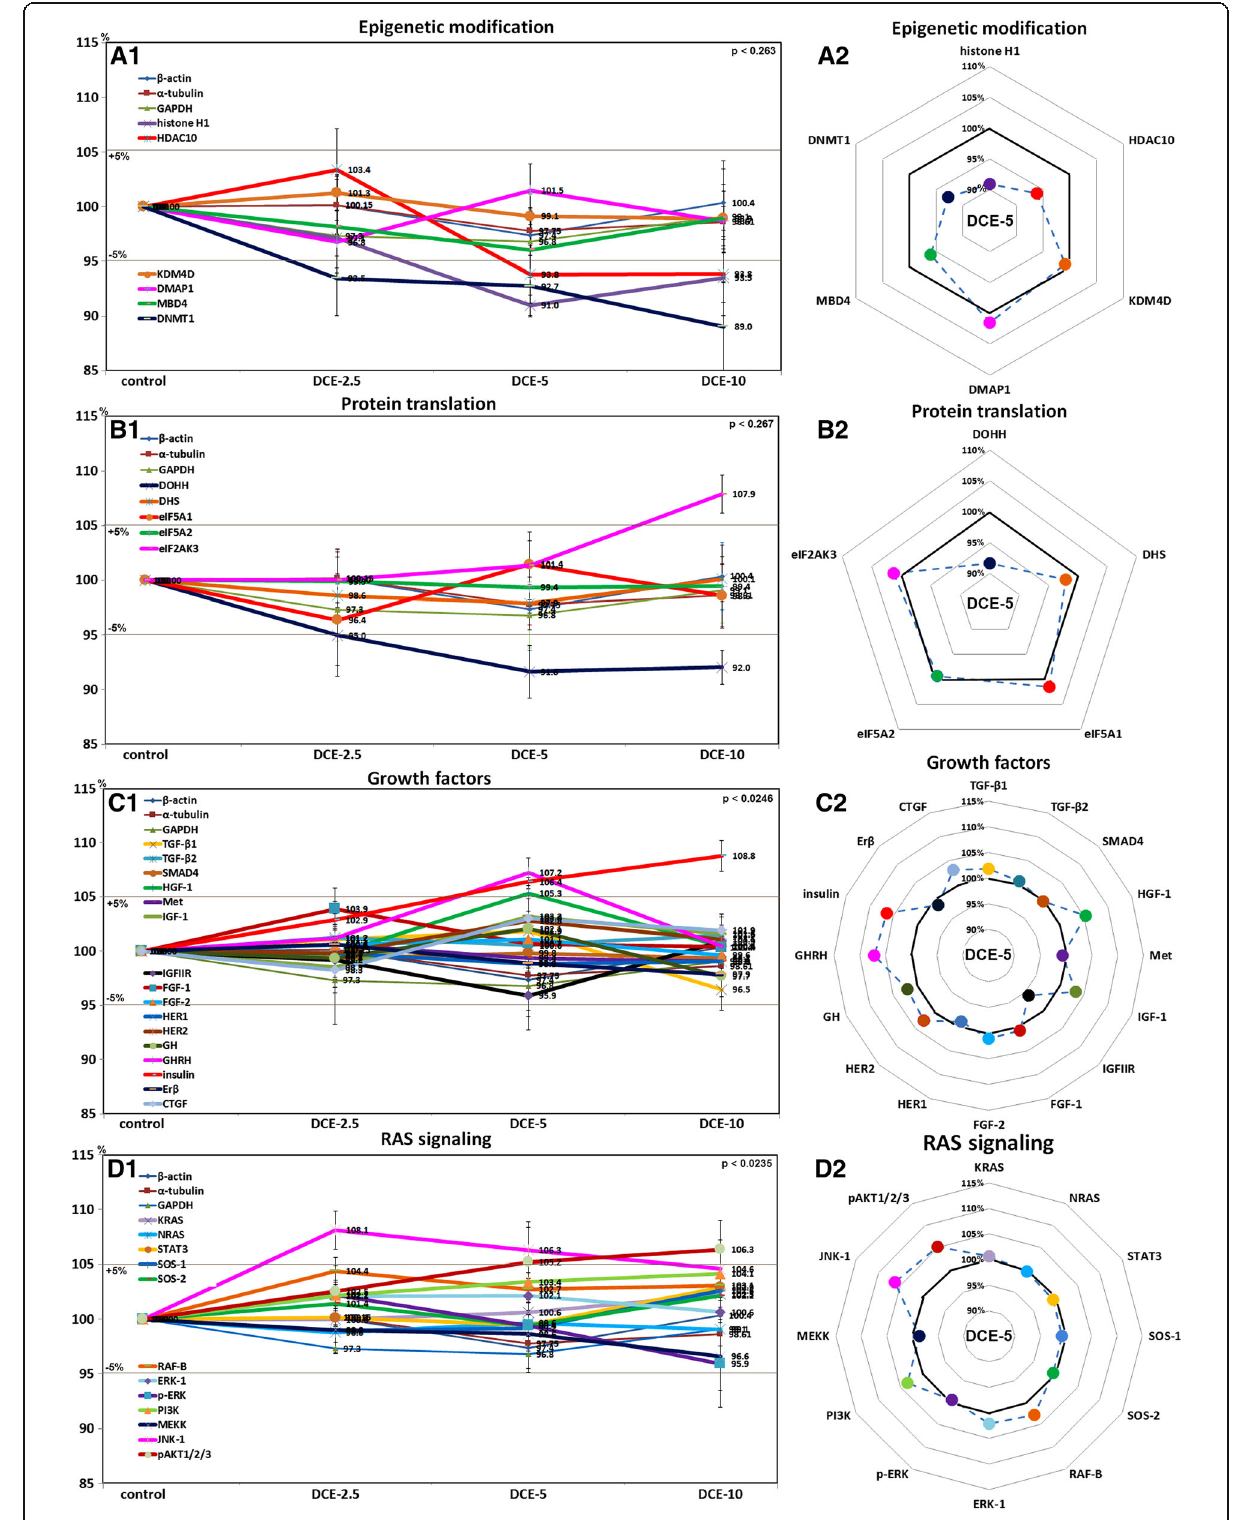
Fig. 4 Expressions of epigenetic modification-related proteins ( a ), protein translation-related proteins ( b ), growth factors ( c ), and RAS signaling proteins ( d ) after DCE treatment in mouse livers as determined by IP-HPLC. Major protein expression pattern induced by DCE-5 was found in the radial graphs of A2, B2, C2, and